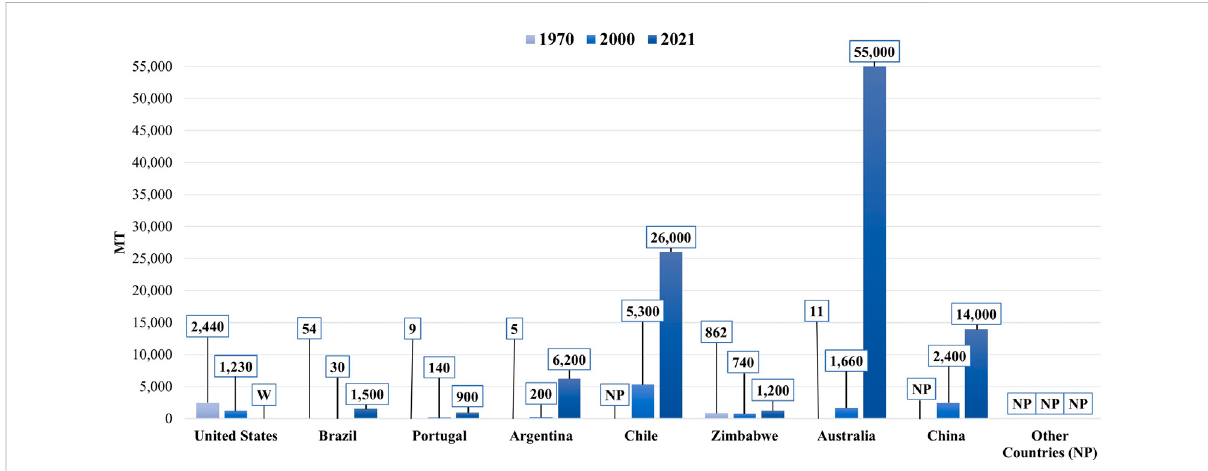
FIGURE 2 A bar chart showing the annual lithium production by country in 1970, 2000, and 2021. Note that the countries labeled with “ NP ” reported no data that year. Additionally, the United States withheld (W) its production data in 2021 (U.S Geological Survey, 2022; Mohr et al., 2012).